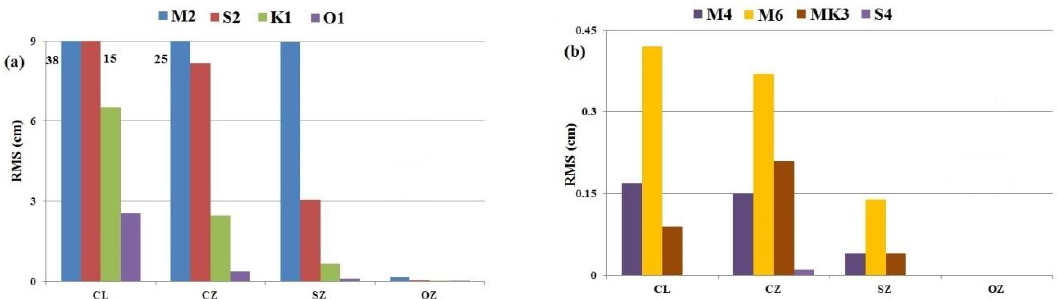
Figure 5. The mean RMS errors of the difference between two bathymetry models in estimating four major ( a ) and four shallow water ( b ) constituents. The RMS value in ( a ) is >9 cm. The values over Ocean Zone (OZ) are equal or close to zero.